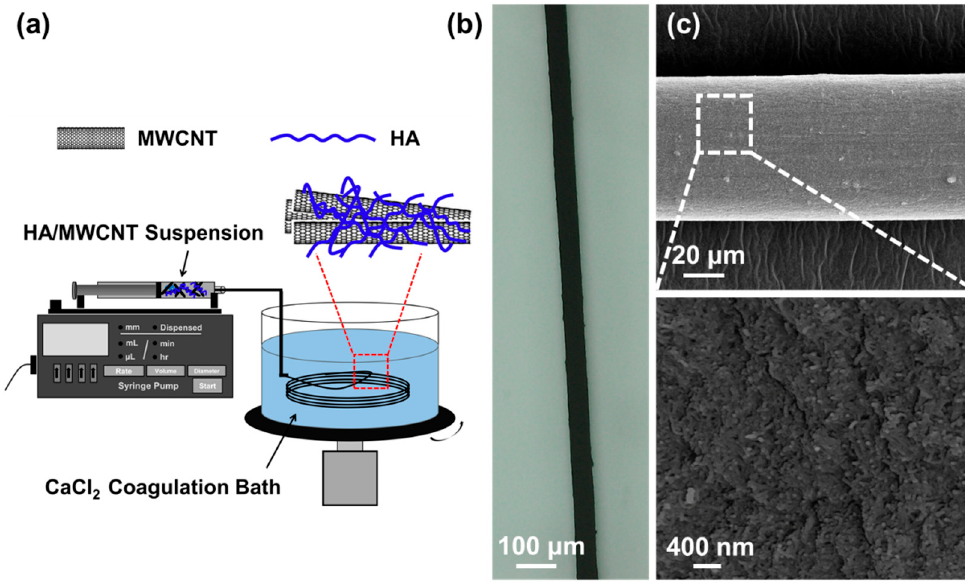
Figure 2. ( a ) A schematic of the experimental design of the wet-spinning method. ( b ) 3D microscopy image of the HA / MWCNT hybrid microfibers drawn from the CaCl 2 coagulation bath. ( c ) SEM image of the HA / MWCNT hybrid microfibers and an enlarged image of the fibers.